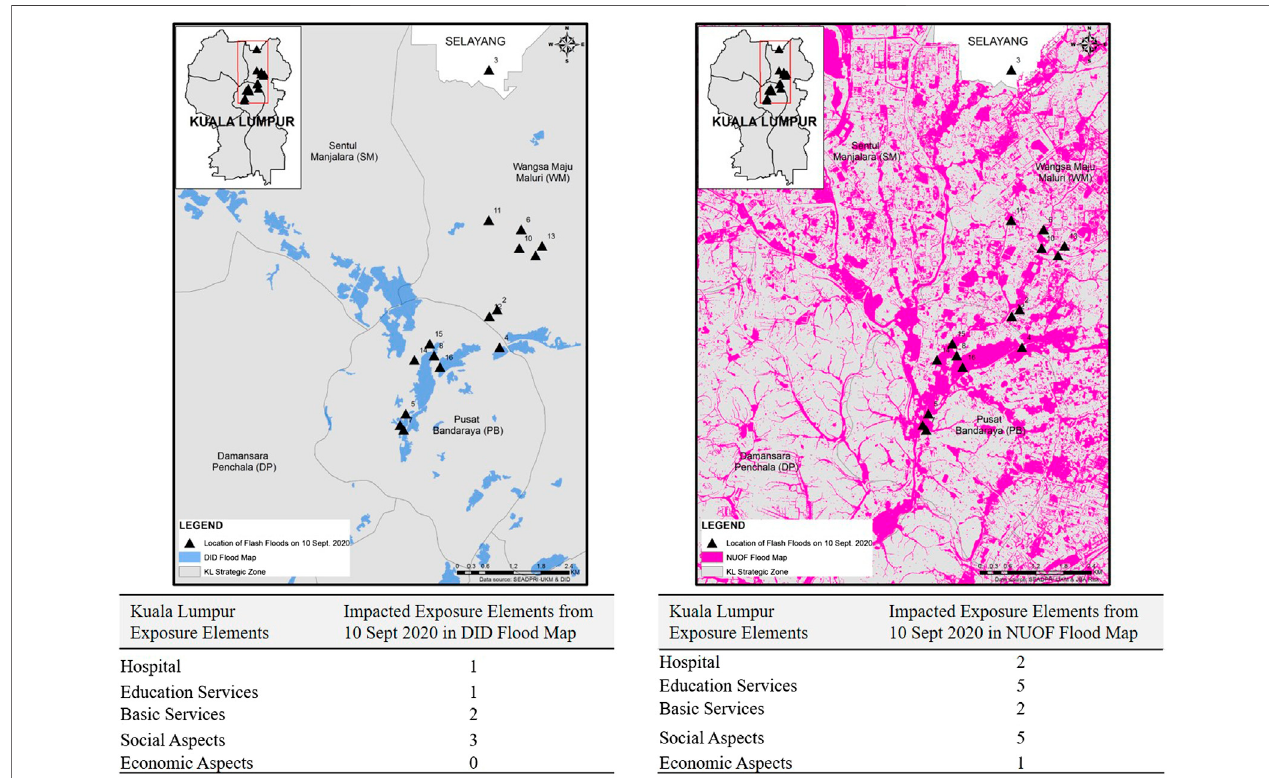
FIGURE 4 | The extent of fl ood hazard zones of DID and fl ood susceptibility areas of the NUOF research consortium, with number of exposure elements therein. The numbered vicinities are available in Figure 3 .